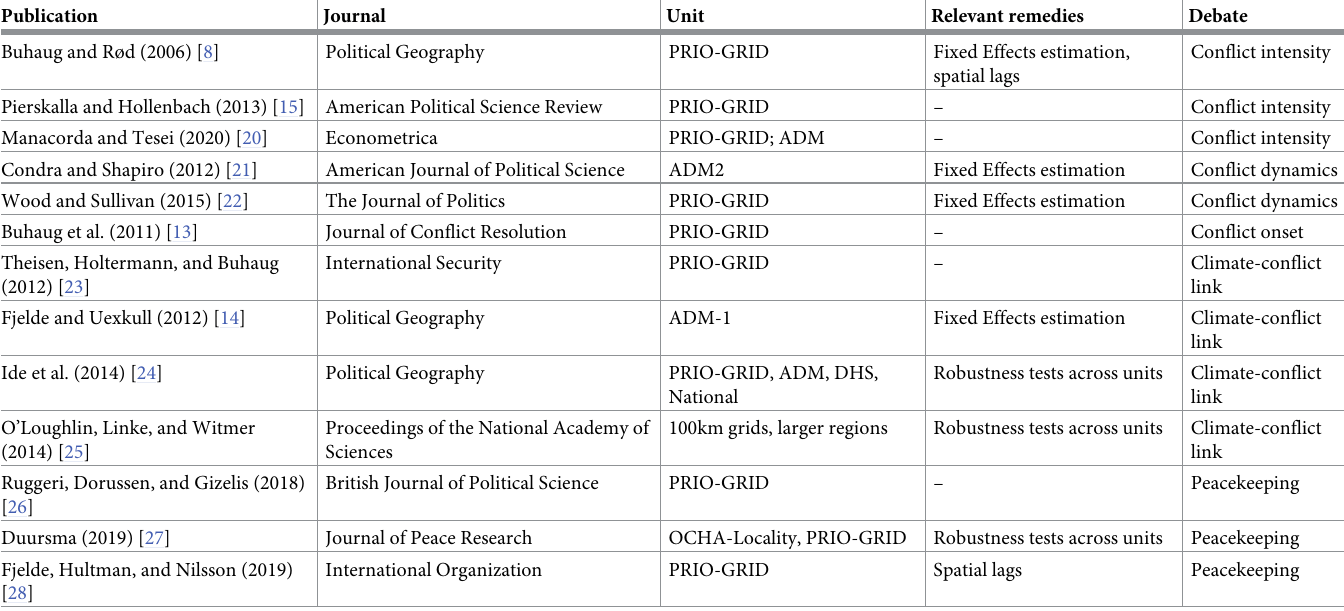
Table 1. Thirteen influential SEA designs published largely in the last